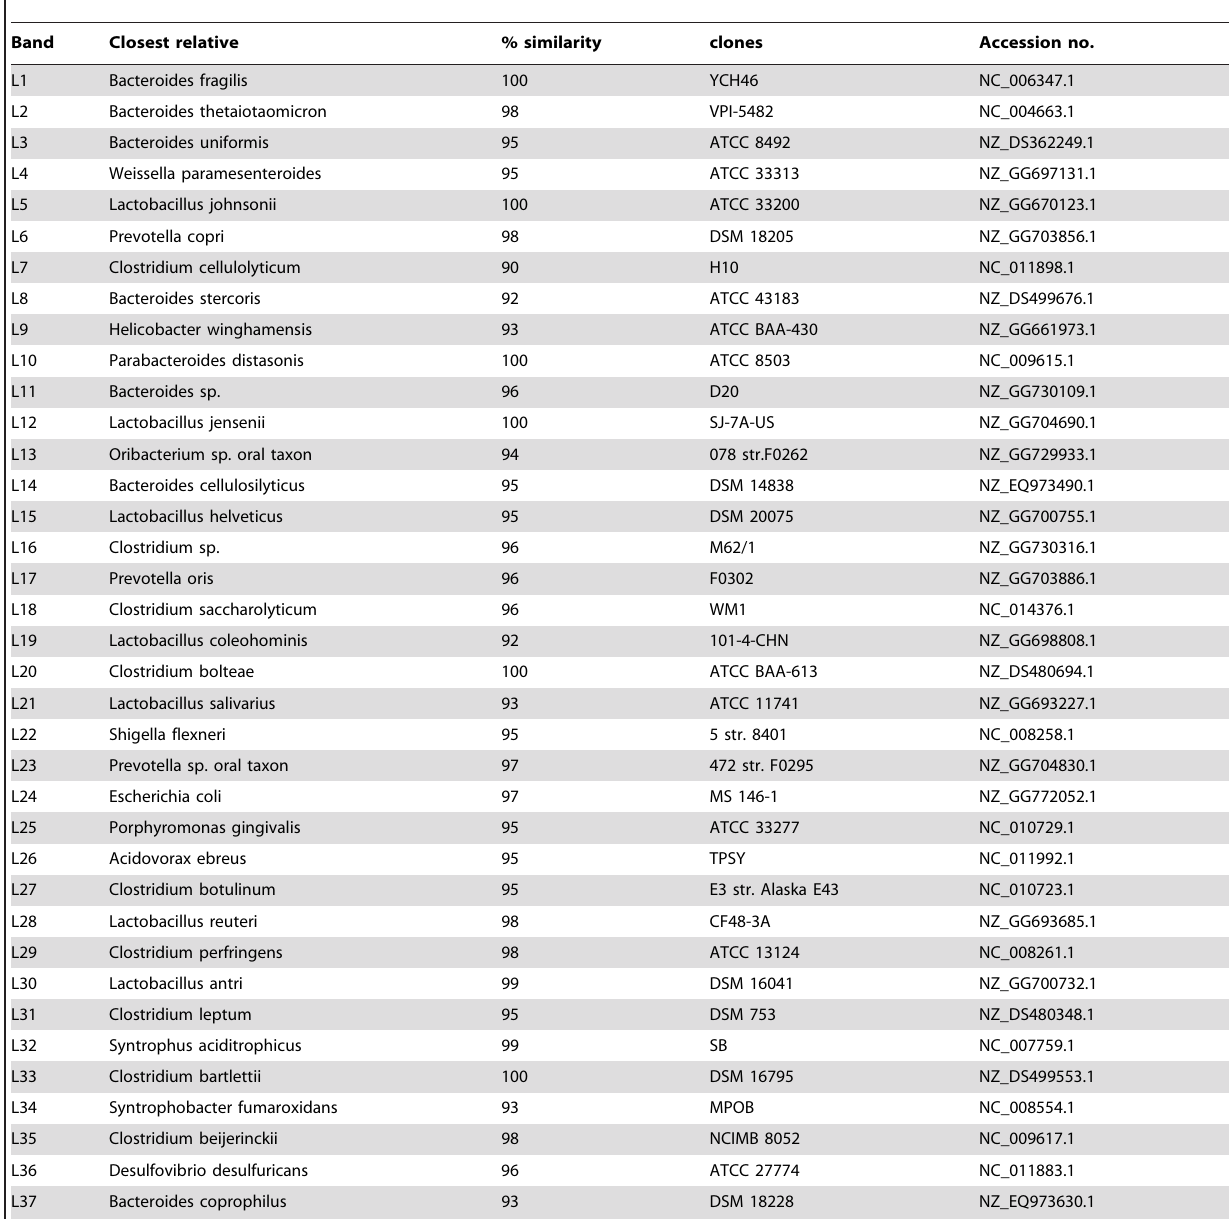
Table 1. Similarities of 16S rDNA gene sequences of luminal microbiota with closest match sequences retrieved.